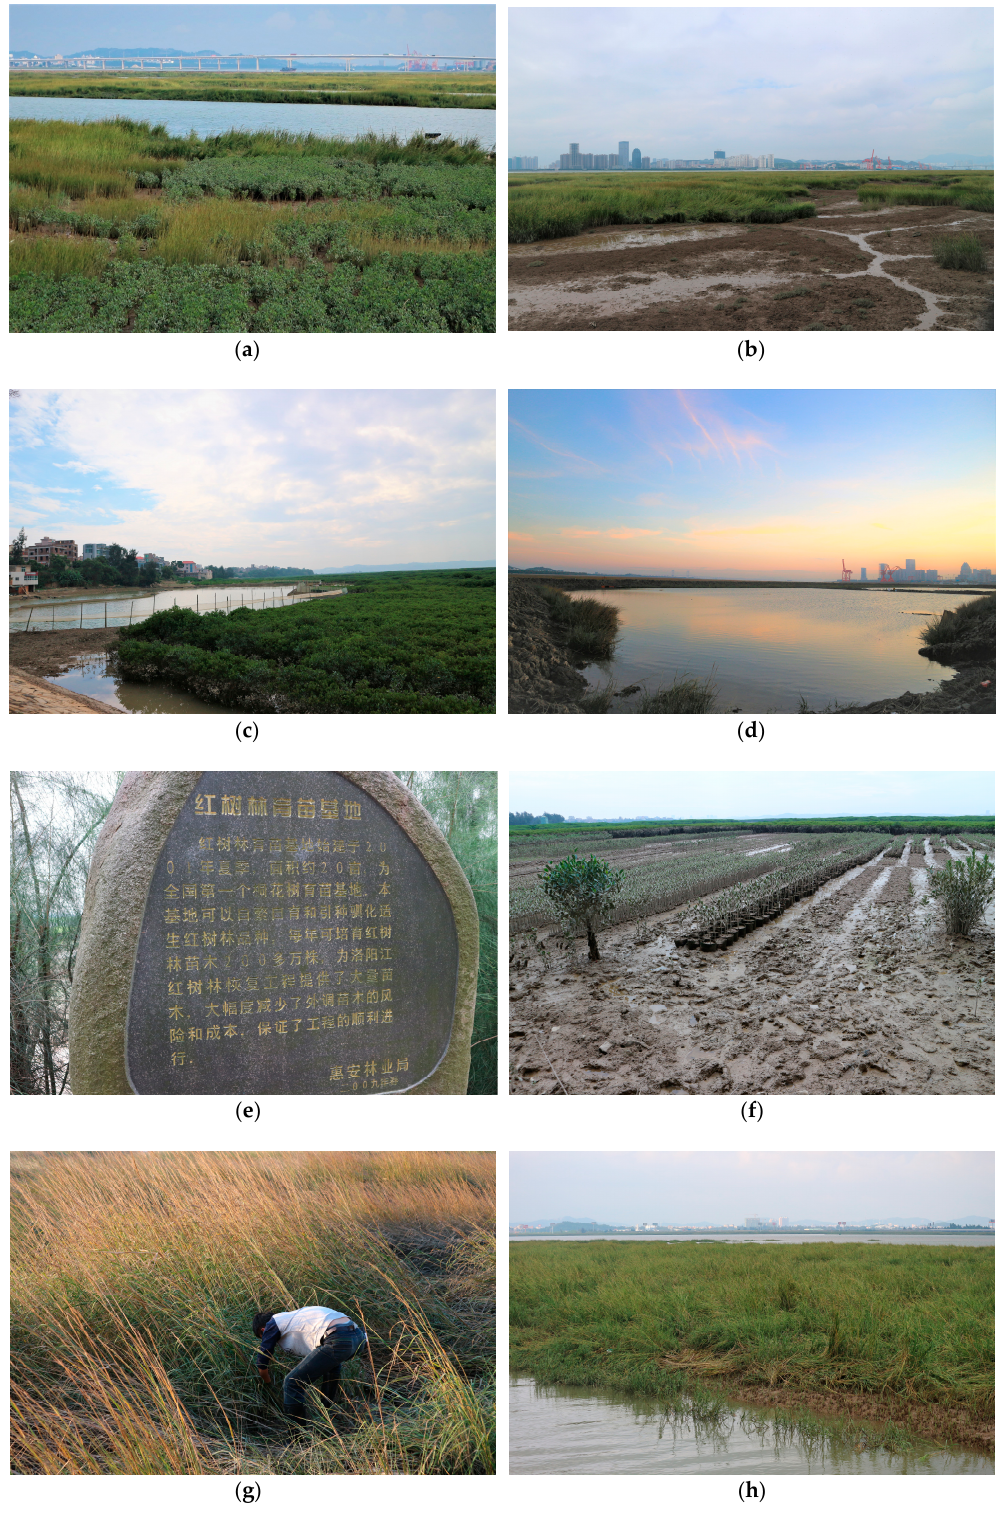
Figure 8. Positive and negative effects for mangrove forests. ( a ) Spartina invading the mangrove seedling area; ( b ) Spartina expansion into mudflats; ( c ) aquaculture ponds as a threat to mangrove forests; ( d ) aquaculture development in mudflats; ( e ) mangrove seedling milestone recorded during the mangrove afforestation project carried out initially in 2001; ( f ) mangrove seedling cultivation base; ( g ) artificial control of Spartina by mowing; ( h ) Spartina were cut